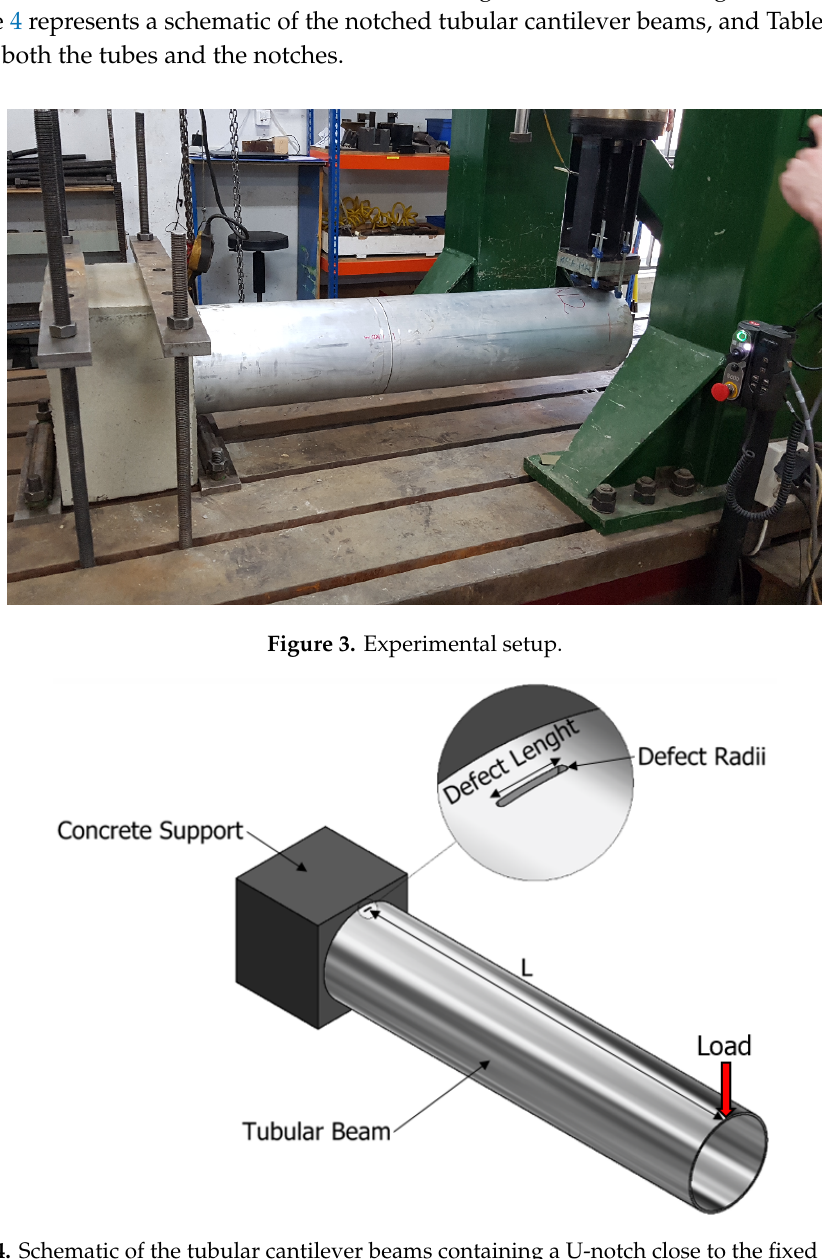
Figure 4. Schematic of the tubular cantilever beams containing a U-notch close to the fixed support. Table 2. Geometrical parameters of the tubes and their corresponding U-notch: Ø , outer diameter; B , tube thickness; D , distance from concrete support to notched section; L , distance from applied load to notched section; 2a , defect length; ρ , defect radius. Dimensions in mm.